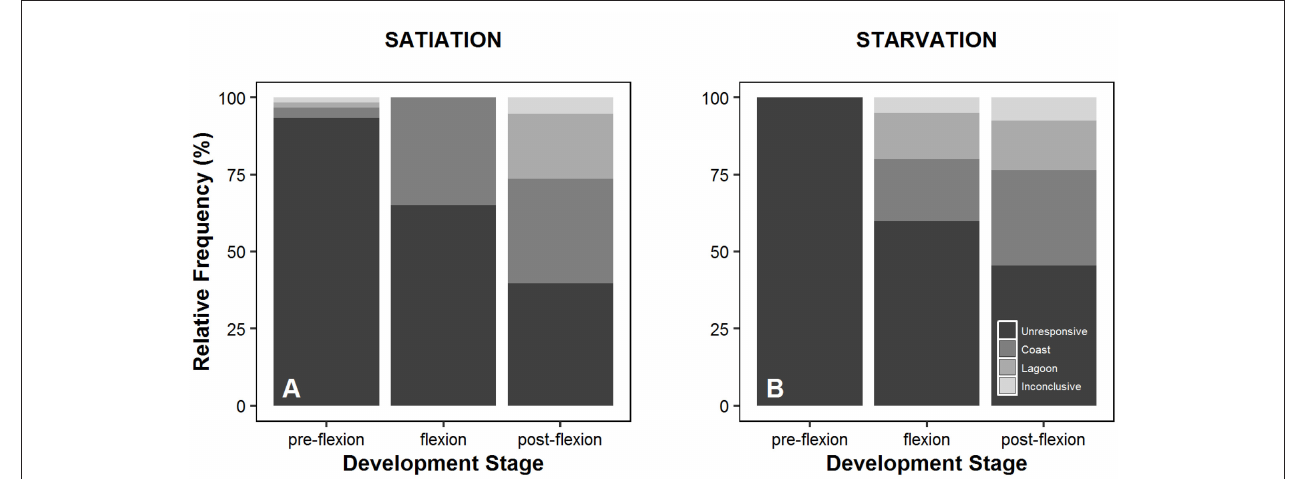
found in the absolute frequencies observed between all levels and starvation) ( χ 2 test, p = 0.000), and for the level pre-flexion